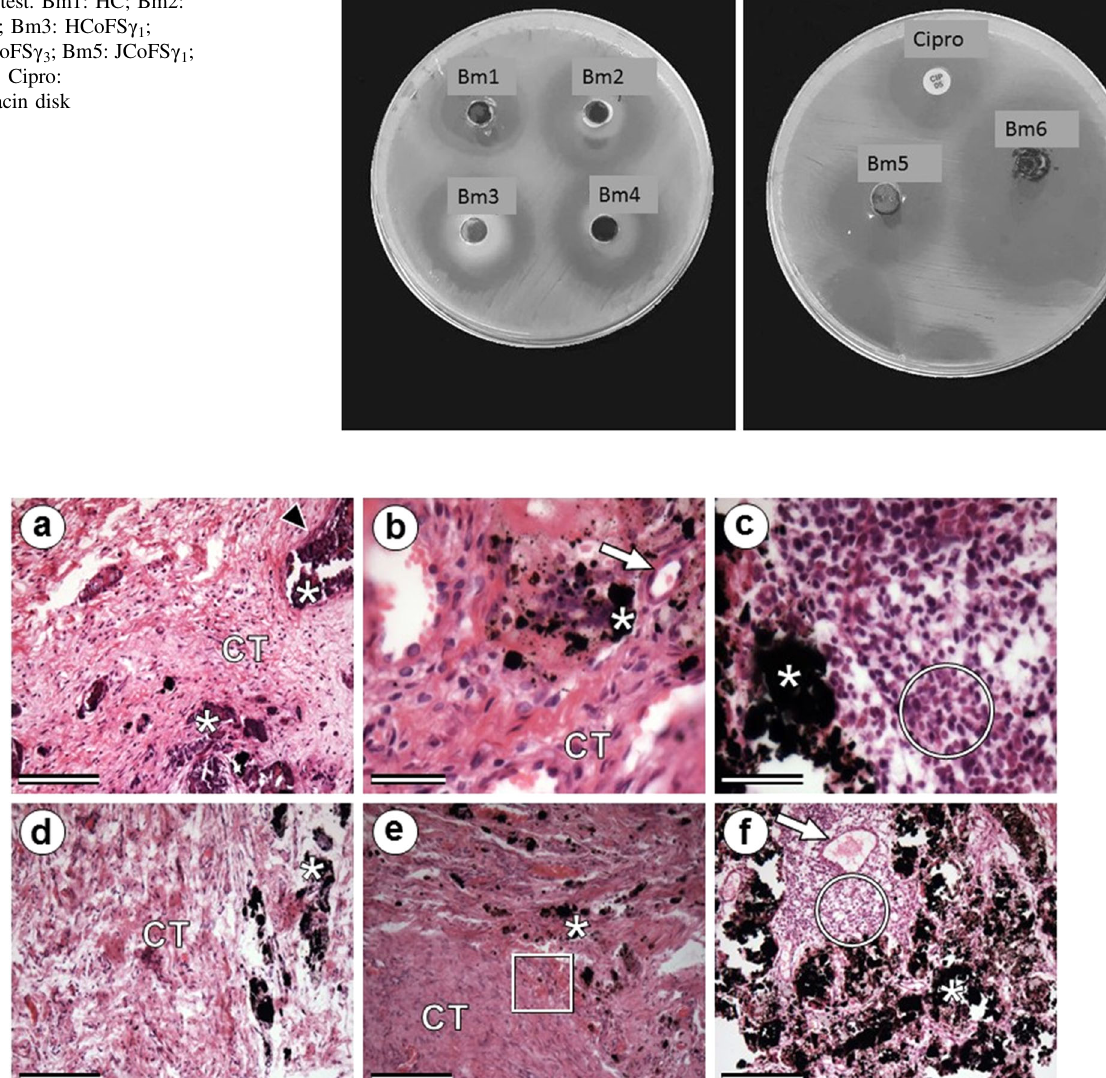
Fig. 4 Photomicrographs at 15 ( a and b ), 30 ( c ), and 70 ( d , e , and f ) days after implantation of biomaterials. ( a ) HCo γ 1 ; ( b ) HCo γ 2 ; ( c ) HCo γ 3 ; ( d ) C γ ; ( e ) and ( f ) HC. Asterisk: biomaterial; red arrow: